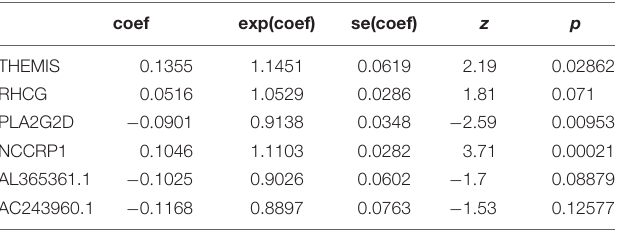
TABLE 5 | Univariate Cox analysis for lifetime-predicted value of genes (TOP 20). TABLE 6 | Multivariate Cox analysis for lifetime-predicted value of genes coxph(formula = Surv(futime, fustat) ∼ THEMIS + RHCG + PLA2G2D + NCCRP1 + AL365361.1 + AC243960.1, data = rt).